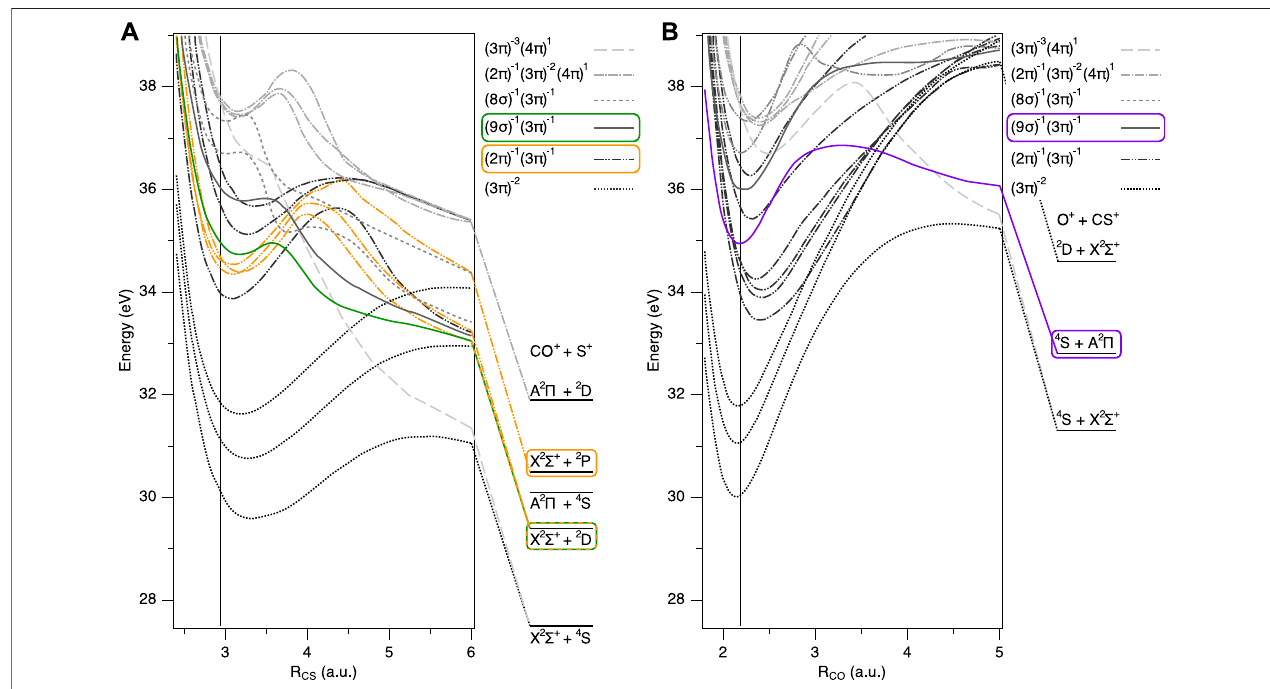
FIGURE2| Potential energy curves oflowerlying electronic statesofOCS 2+ and correspondingdissociation limits, dissociating to (A) OC + + S + ( R CO =2.185a. u.) and (B) O + + CS + ( R CS =2.95 a. u.) (Brites et al., 2008). The bending angle is fi xed at 180 ° . Vertical lines correspond to the equilibrium geometry of neutral OCS in the ground state. Dotted lines correspond to (3 π ) − 2 states ( X 3 Σ − , a 1 Δ , b 1 Σ + ), dash-double dotted lines correspond to (2 π ) − 1 (3 π ) − 1 states (1 1 Σ − , 1 3 Δ , 1 1 Σ + , 2 3 Σ − , 2 1 Δ , 2 1 Σ + ), solidlinescorrespondto(9 σ ) − 1 (3 π ) − 1 states(1 3 Π ,1 1 Π ),brokenlinescorrespondto(8 σ ) − 1 (3 π ) − 1 states(2 3 Π ,2 1 Π ),dash-dottedlinescorrespondto(2 π ) − 1 (3 π ) − 2 (4 π ) 1 states (2 1 Σ − , 2 3 Δ , 2 3 Σ + ), and dashed lines correspond to (3 π ) − 3 (4 π ) 1 states (1 5 Σ − ). The latter two states include electron excitation to a vacant 4 π orbital. The potential energy curves and corresponding dissociation limits mainly responsible for the KER peaks in Figure 3 are highlighted in green, orange, and purple.